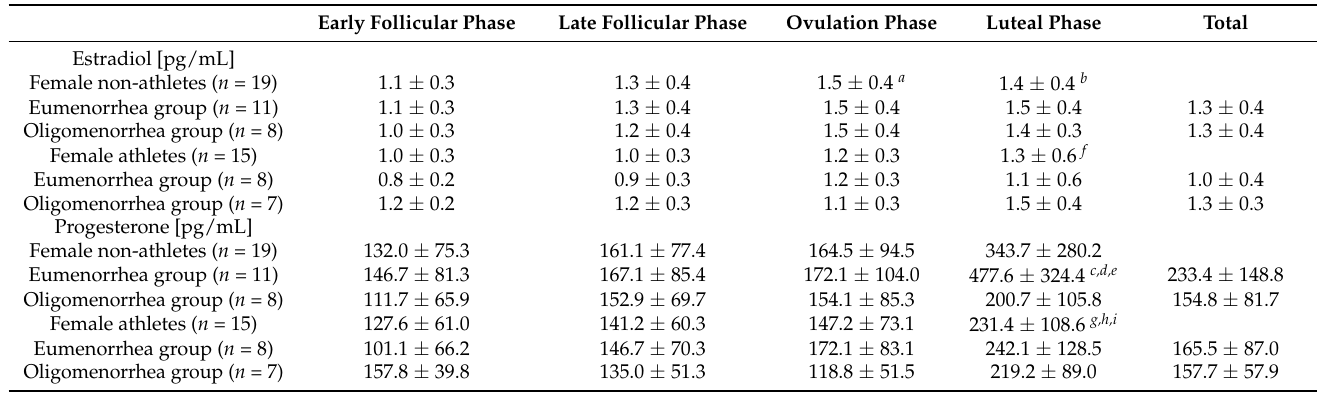
Table 1. Changes in estradiol and progesterone concentrations during the menstrual cycle.